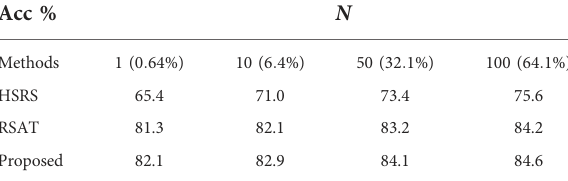
TABLE 5 Test accuracies when N changes ( M ¼ 1 ) of our approach and baselines.